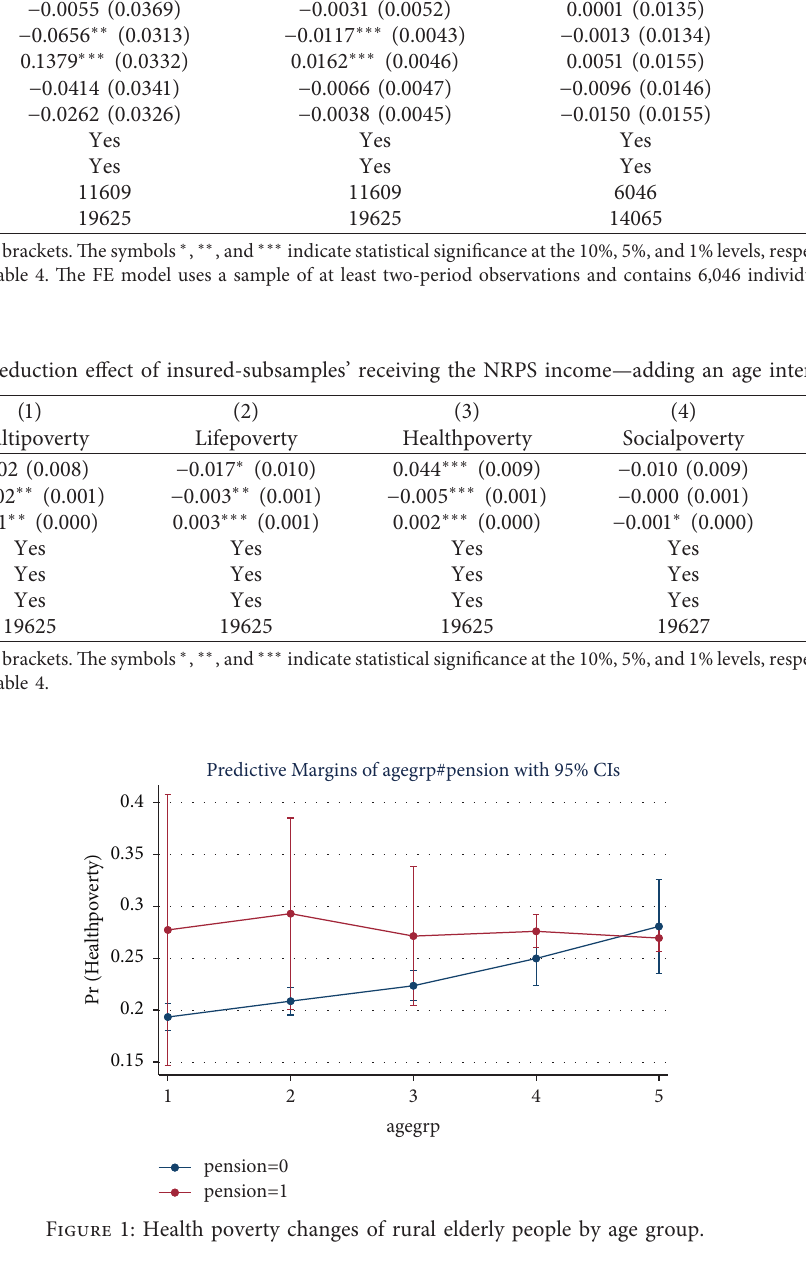
Table 6: Poverty-reduction effect of insured-subsamples’ receiving the NRPS income. Variable